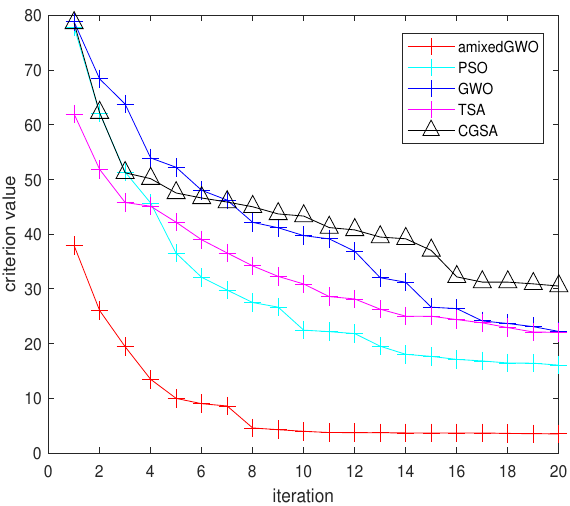
Figure 16. Arithmetic mean of the convergence curves for amixedGWO, PSO, GWO, TSA, CGSA.